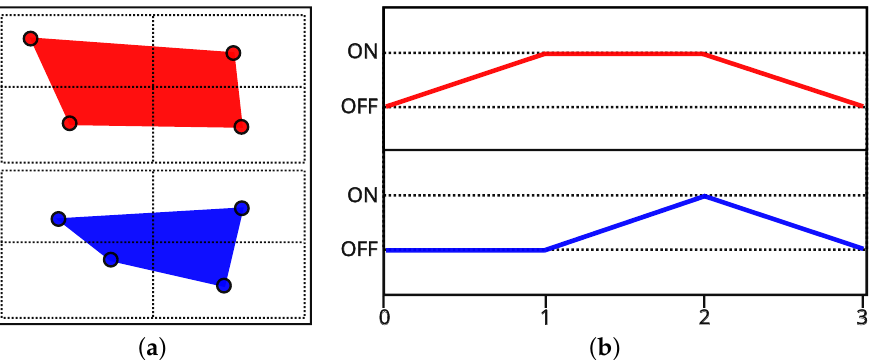
Figure 5. Unit definitions. ( a ) The chamber layout within a unit. The dotted lines represent the boundaries of each chamber node. ( b ) Actuation pattern. Both chambers start and end at the off position, and this allows for cyclic actuation. Each coloured line corresponds to the actuation of the matching coloured chamber.